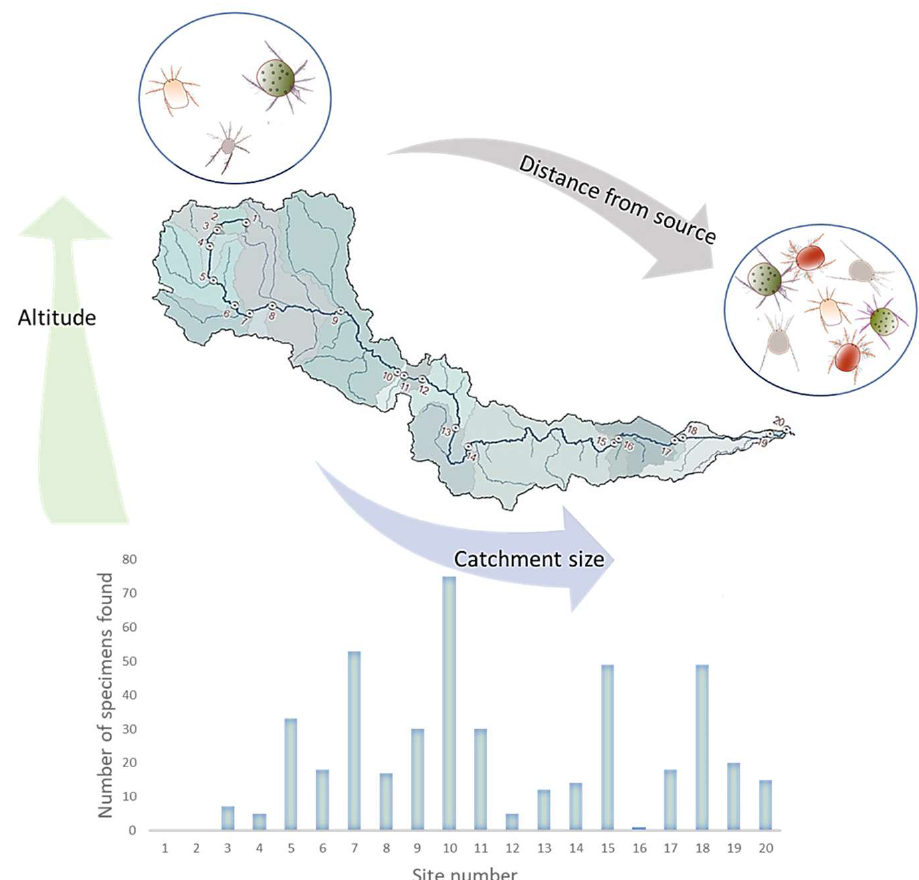
Figure 2. Graphical presentation of the three main longitudinal characteristics of the study area that significantly correlate with abundance and species richness of water mites. Distance from the source (m) and catchment size (km 2 ) are significantly and positively correlated with abundance and species richness, while altitude (m a.s.l.) is significantly and negatively correlated with abundance and species richness of water mites.